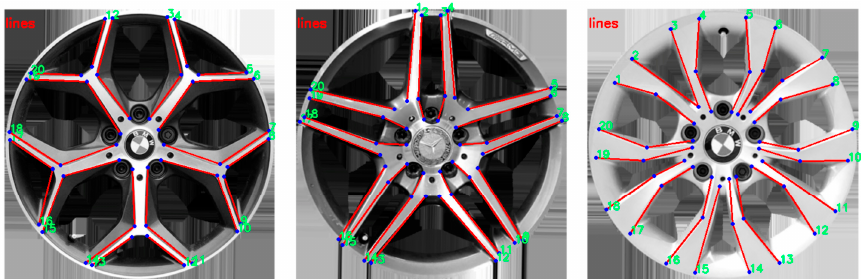
Figure 12. Boundary transformation of spokes. The boundaries (red lines) on either side of each spoke were sorted clockwise, and the feature points (blue dots) on each boundary were sorted according to their distance from the center of the wheel hub. The sorted feature points were used to determine the degree of similarity by performing a distance calculation with the original feature points at the corresponding locations.